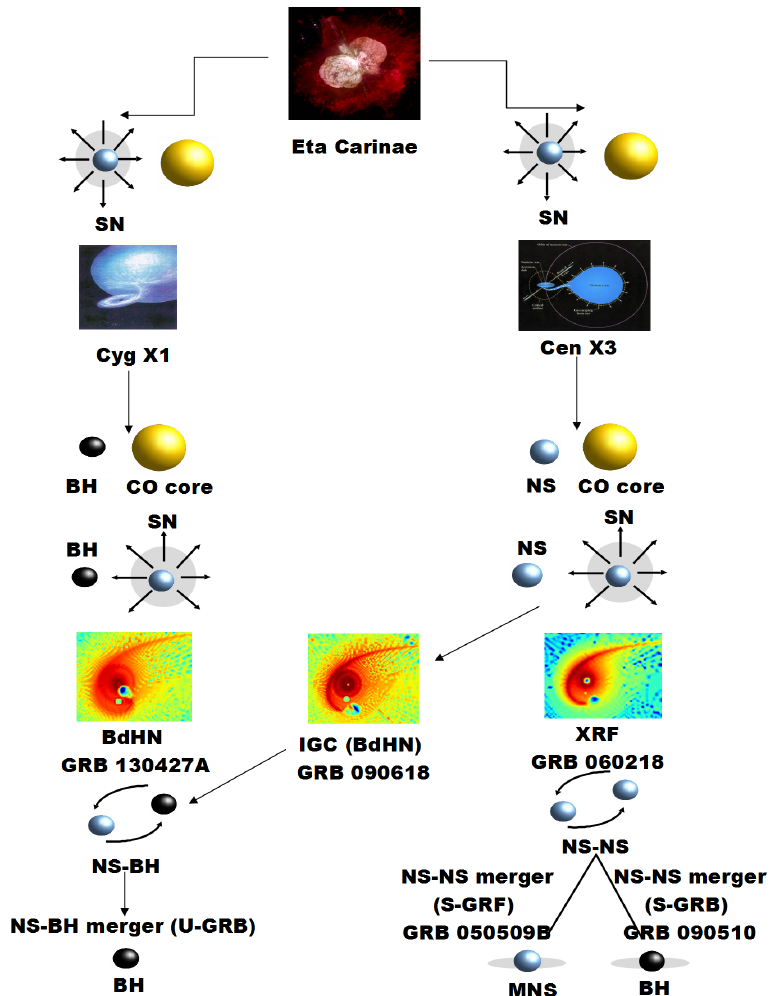
Figure 1. Taken from Figure 1 in [80]. Binary evolutionary paths leading to BdHNe I (previously named BdHNe) and II (previously named XRFs) and whose out-states, in due time, evolve into progenitors of short GRBs. The massive binary has to survive two core-collapse SN events. The first event forms a NS (right-side path) or BH (left-side path). The massive companion continues its evolution until it forms a CO core . This simplified evolution diagram which does not show intermediate stages such as common-envelope phases (see e.g., [53,55], and references therein). At this stage the binary is a CO core -NS (right-side path) or a CO core -BH (left-side path). Then, it occurs the second SN event which forms what we call the ν NS at its center. We focus in this article to review the theoretical and observational aspects of interaction of this SN event with the NS companion (BdHNe I and II). We do not treat here the case of a SN exploding in an already formed BH companion (BdHNe IV). At this point the system can form a ν NS-BH/NS (BdHN I/II) binary (right-side path), or a ν NS-BH (BdHN IV) in the (left-side path). The emission of gravitational waves will make this compact-object binaries to merge, becoming progenitors of short GRBs [55]. We recall to the reader that S-GRBs and S-GRFs stand for, respectively, authentic short GRBs and short Gamma-ray flashes, the two subclasses of short bursts from NS-NS mergers, the former produced when the merger leads to a more massive NS and the latter when a BH is formed